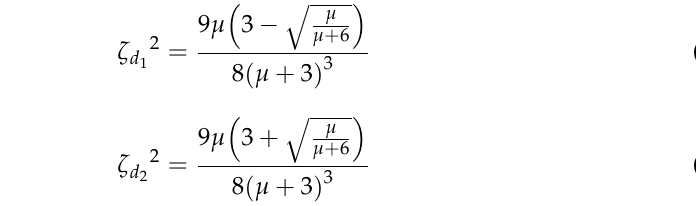
Since the difference between the two values is small, the average value is taken as the optimal damping ratio